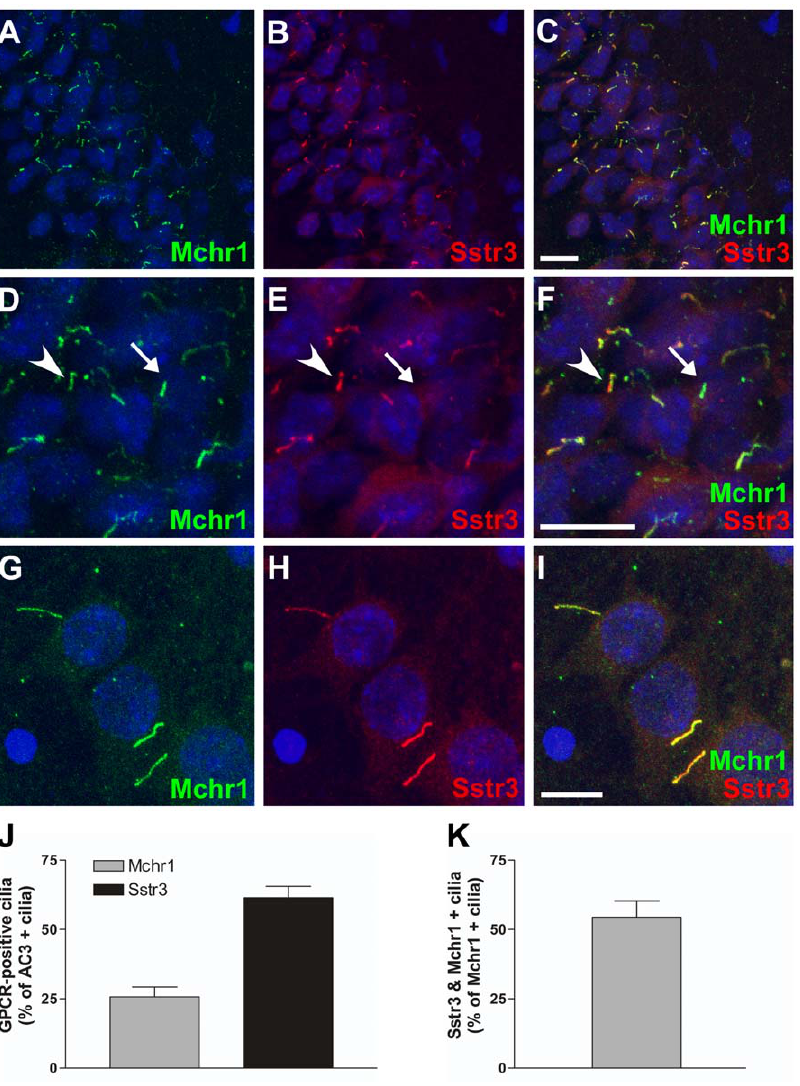
Figure 2. Mchr1 and Sstr3 colocalize in a subset of hippocampal neuronal cilia. (A–F) Representative image of the CA1 region of the hippocampus from an adult WT mouse colabeled for Mchr1 (green) and Sstr3 (red). Nuclei are stained with DRAQ5 (blue). Labeling for Mchr1 (A) and Sstr3 (B) reveals the presence of Mchr1- and Sstr3-positive cilia in the hippocampus. Merged image (C) shows colocalization of Mchr1 and Sstr3 on a subset of neuronal cilia. Zoomed in image (D–F) reveals a subset of neuronal cilia that are positive for Mchr1 only (arrow) and a subset that are positive for both Mchr1 and Sstr3 (arrowhead). (G–I) Colabeling of day 7 WT hippocampal neurons with antibodies to Mchr1 (green) and Sstr3 (red). Nuclei are stained with DRAQ5 (blue). Merged image (I) shows Mchr1 and Sstr3 colocalization within the same cilium in vitro . (J) Quantification of day 7 WT hippocampal neurons colabeled for Mchr1 and AC3 or Sstr3 and AC3 reveals that Mchr1localizes to 25.73 6 3.53% (n=239) of AC3-positive cilia and Sstr3 localizes to 61.46 6 4.12% (n=221) of AC3-positive cilia. (K) Graphical representation of the quantification of day 7 WT hippocampal neurons colabeled for Mchr1 and Sstr3 shows Sstr3 colocalizes to 54.43 6 5.78% (n=67) of Mchr1-positive cilia. Scale bars represent 10 m m.